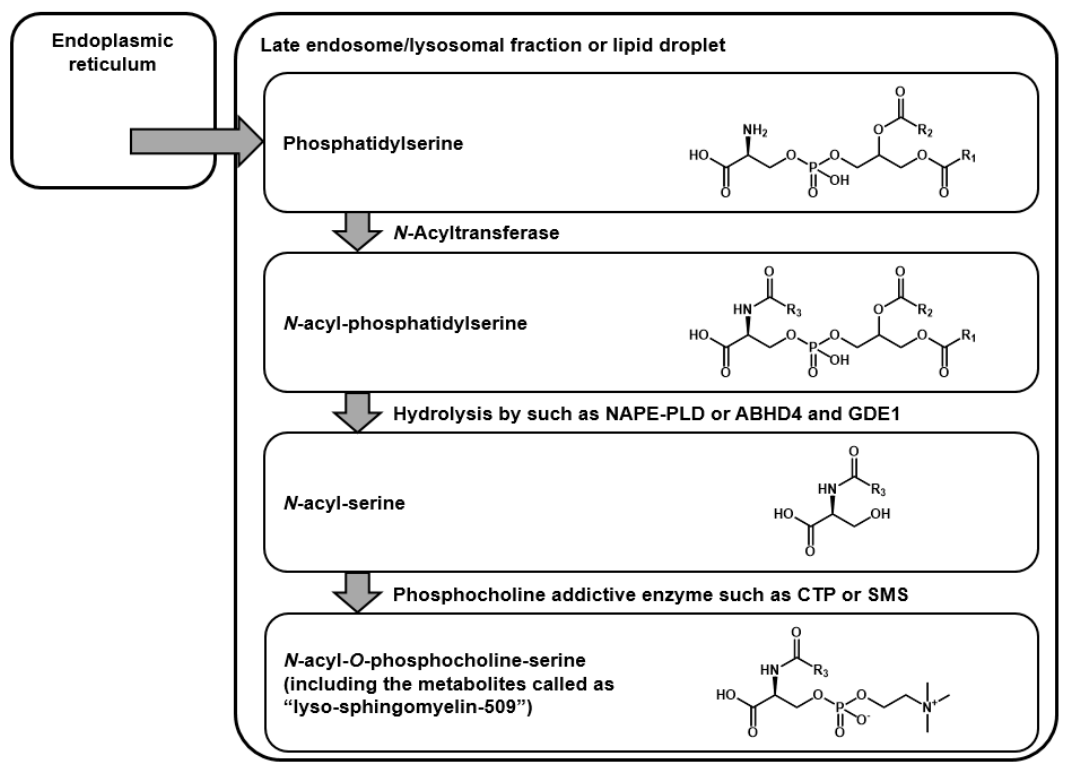
Figure 7. The hypothesis of proposed metabolic pathway of N -acyl- O -phosphocholine-serines.